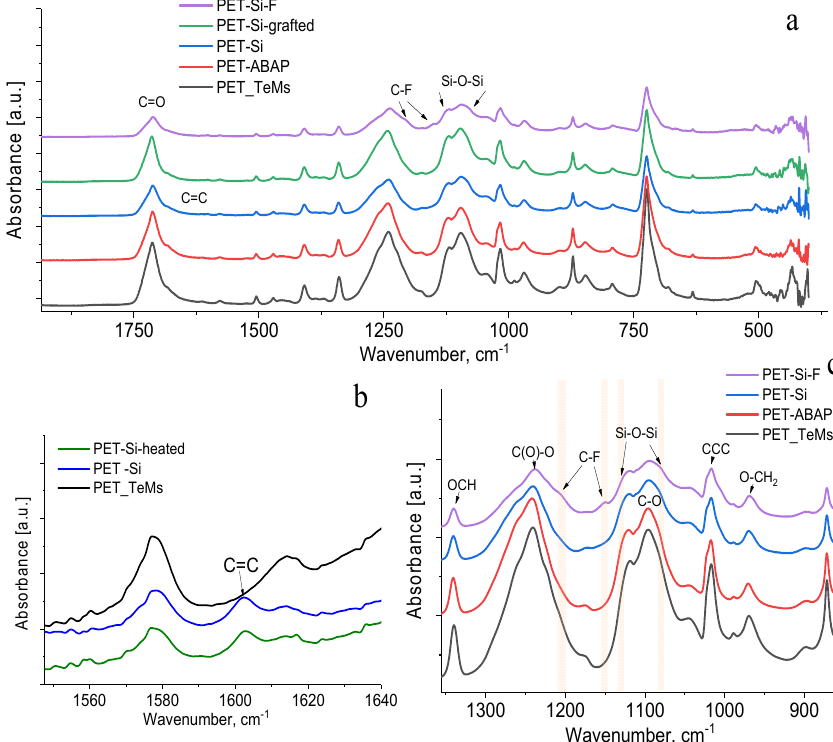
Figure 7. FTIR-ATR spectra of PET ion-track membranes at different stages of modification at wavenumber range from 1800–400 cm − 1 ( a ) from 1560 to 1640 cm − 1 ( b ) and from 1350 to 940 cm − 1 ( c ).